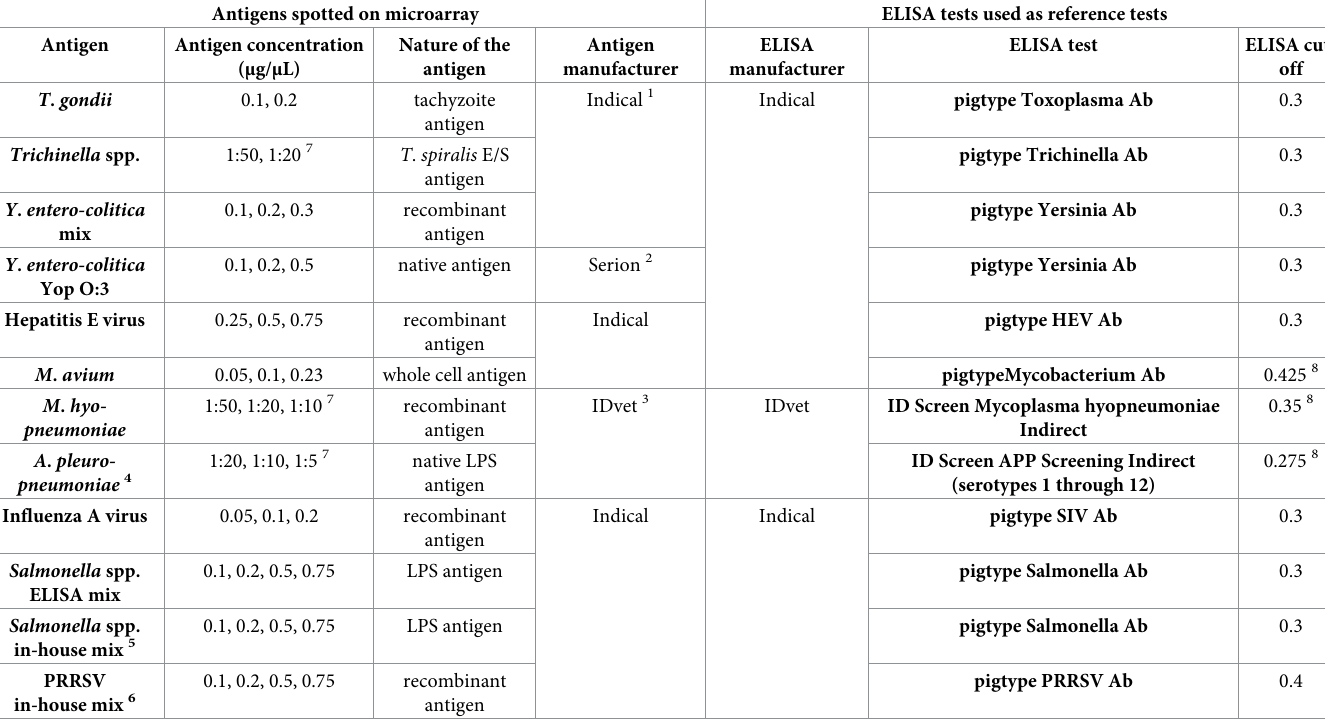
Table 1. Antigens spotted on the microarray chip and ELISA tests used as reference tests. Antigens spotted on